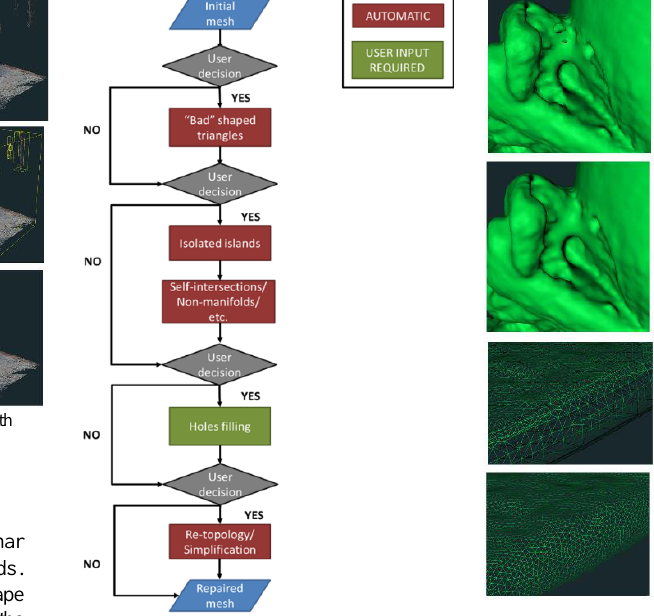
Figure 7: Mesh editing module and examples of the